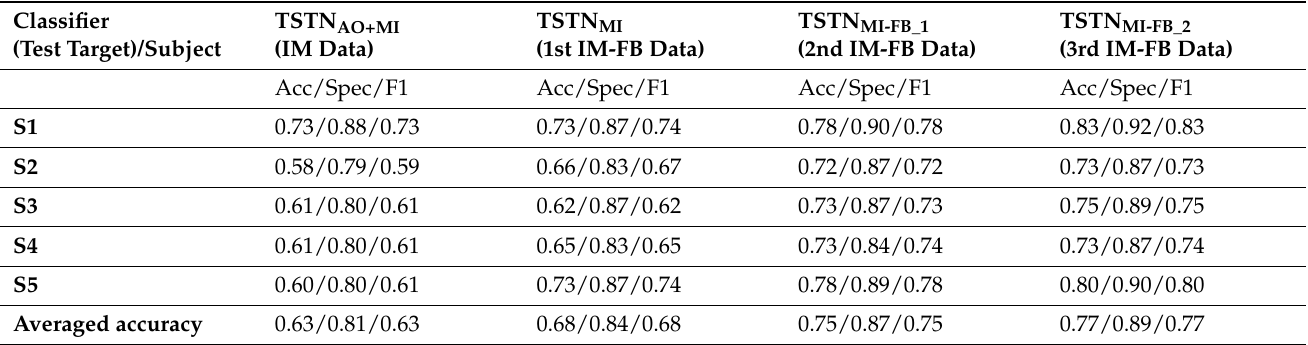
Table 1. Classification results of the TSTN network generated from individual